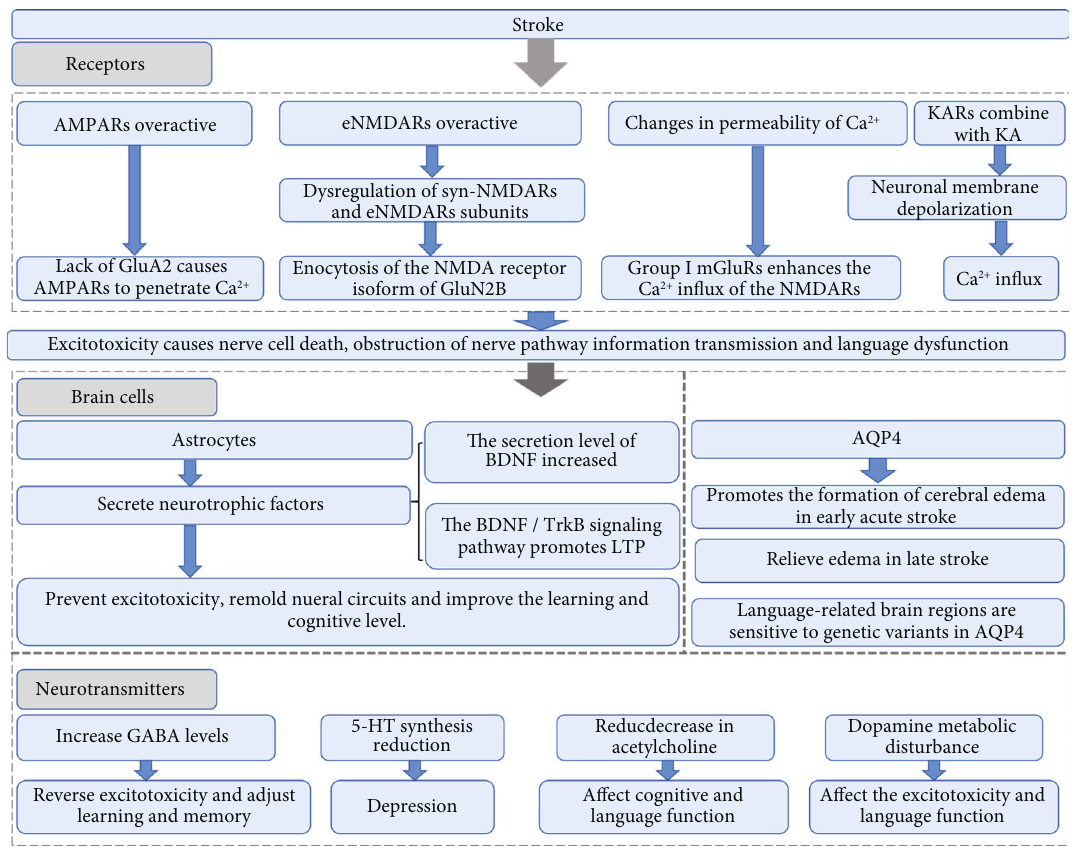
Figure 2: Brain cell, receptor, and neurotransmitter responses after a stroke. AMPAR: α -amino-3-hydroxy-5-methyl-4-isoxazole-propionic acid receptor; NMDA: N -methyl-D-aspartate; Ca 2+ : calcium ion; mGluR: metabotropic glutamate receptor; eNMDAR: extrasynaptic NMDAR; KA: kainic acid; BDNF: brain-derived neurotrophic factor; TrkB: tyrosine kinase receptor B; LTP: long-term potentiation; AQP4: aquaporin 4; GABA: γ -aminobutyric acid; 5-HT: